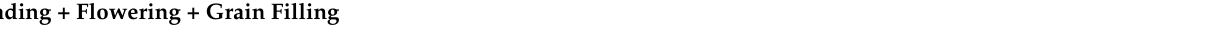
Table 3. Results of the estimation of the yield of winter wheat based on features extracted from three